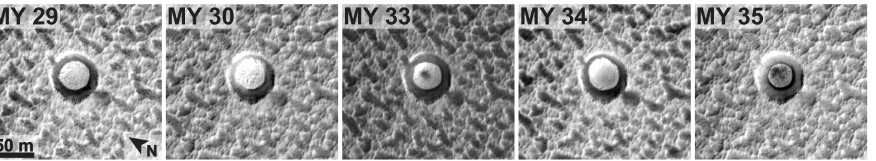
Figure 15. Study of ice accumulation changes at a 60 m diameter crater on the north polar residual cap, 85.6 ◦ N, 58.4 ◦ E. Each image was taken during northern summer when seasonal frost was minimal, allowing for the precise measurement of changes in the persistent ice. Images are orthorectified to DTEPC_044872_2655_044728_2655_A01. Illumination is from the lower right in all frames. A relative contrast stretch has been applied to each